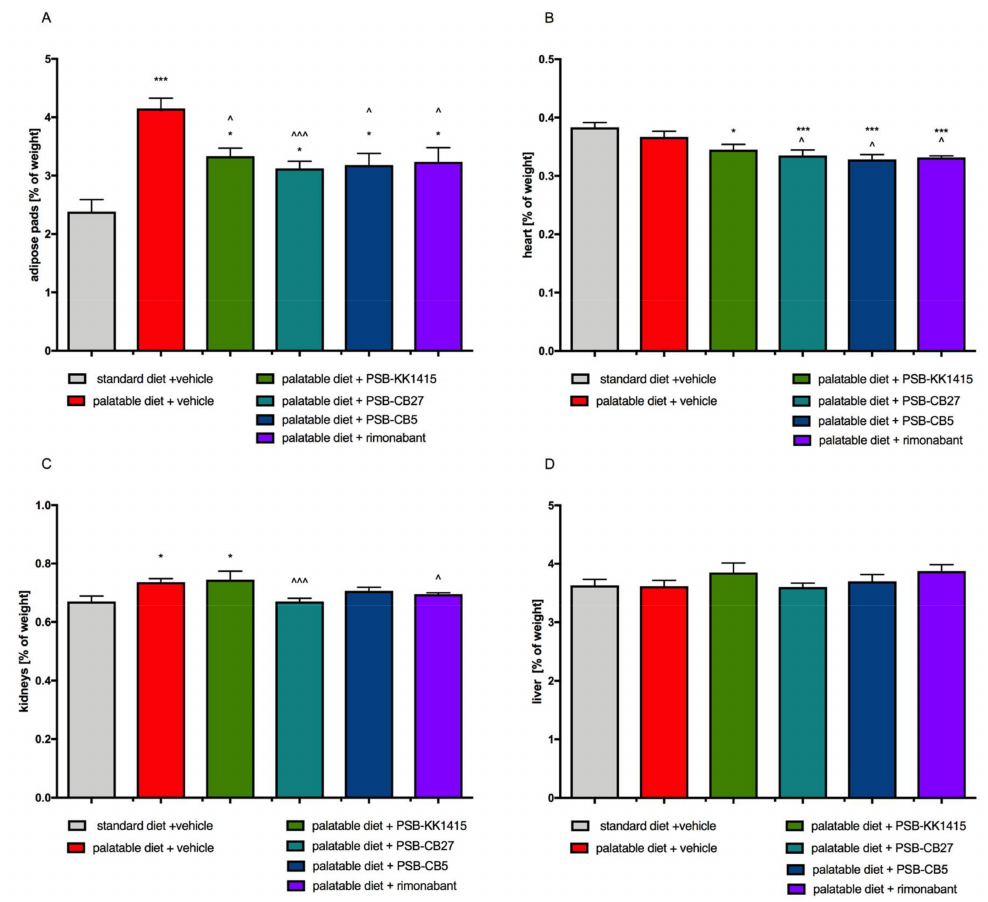
Figure 2. Effect of diet or long-term administration of the GPR18 ligands or rimonabant, on weights of various organs of female Wistar rats in the model of excessive eating. ( A ) Peritoneal adipose tissue. ( B ) Heart. ( C ) Kidneys. ( D ) Liver. Results are the means ± SEM, n = 6. Multiple comparisons against the vehicle-treated control group (*) or against the vehicle-treated obese control group (ˆ) were performed by one-way ANOVA Tukey post hoc; Significant differences are denoted by *,ˆ p < 0.05; ***,ˆˆˆ p < 0.001.